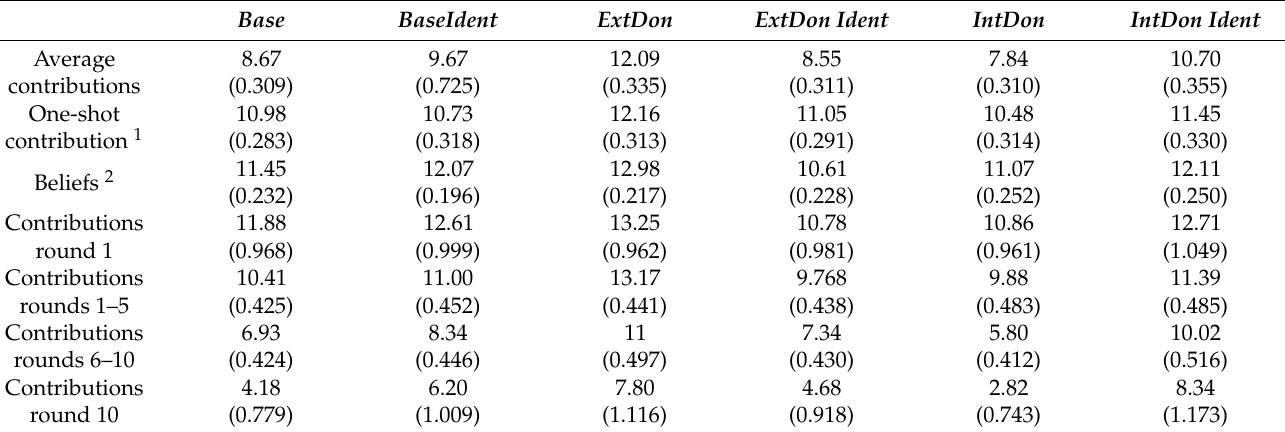
Table 2. Means of one-shot contribution, beliefs, and contribution in